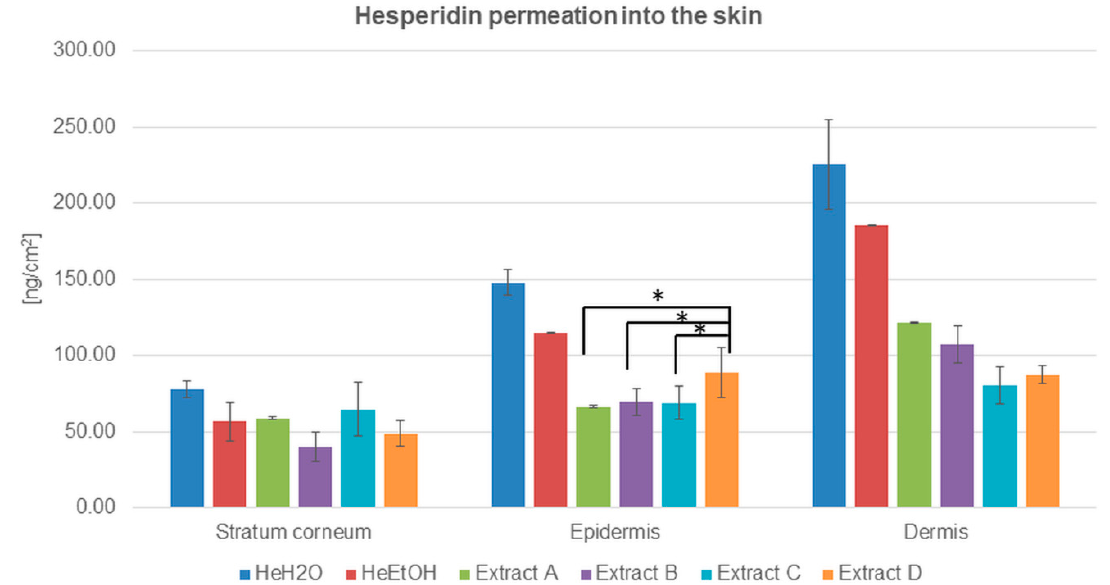
Figure 1. Hesperidin distribution among skin layers: stratum corneum, epidermis, and dermis (ng/cm 2 ) after application and 24 h of incubation with hesperidin solutions: water (HeH 2 O, 4 µ g/mL), ethanol (HeEtOH, 4 µ g/mL, 50% ( v/v )), or honeybush extracts: A, B, C, D. Each average value was obtained from three independent repetitions. Error bars represent standard deviations. Significant differences among samples are marked with an asterisk ( p < 0.05).